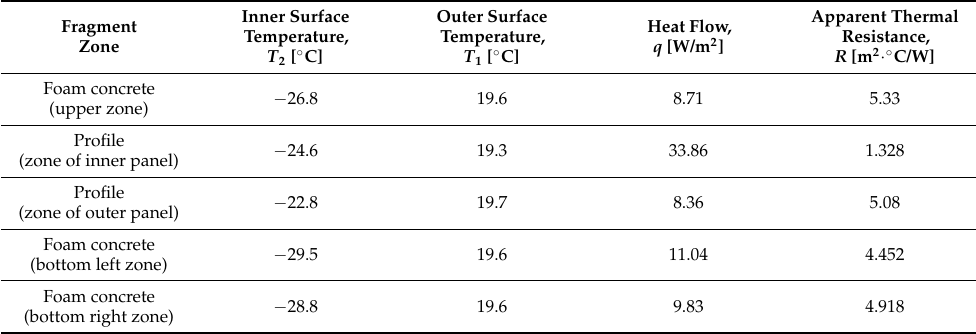
Table 3. Wall fragment with a horizontal field